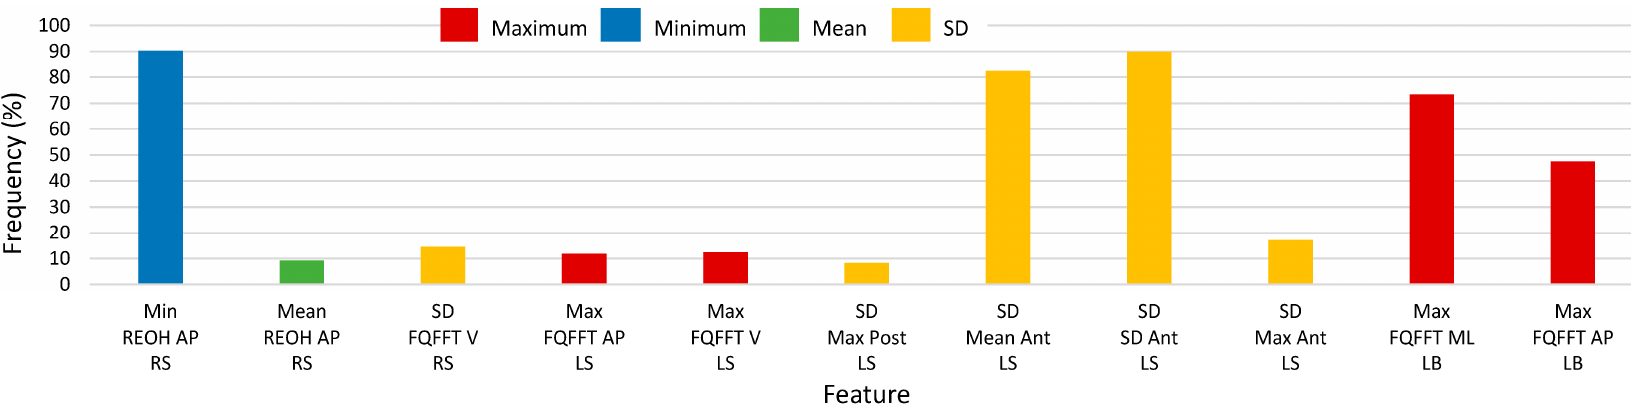
Figure 9. Histogram of selected turn-based feature frequency above 8% (200) of 2500 total selections using the select-5-best (S5B) method for 2500 random-shuffle- split iterations.